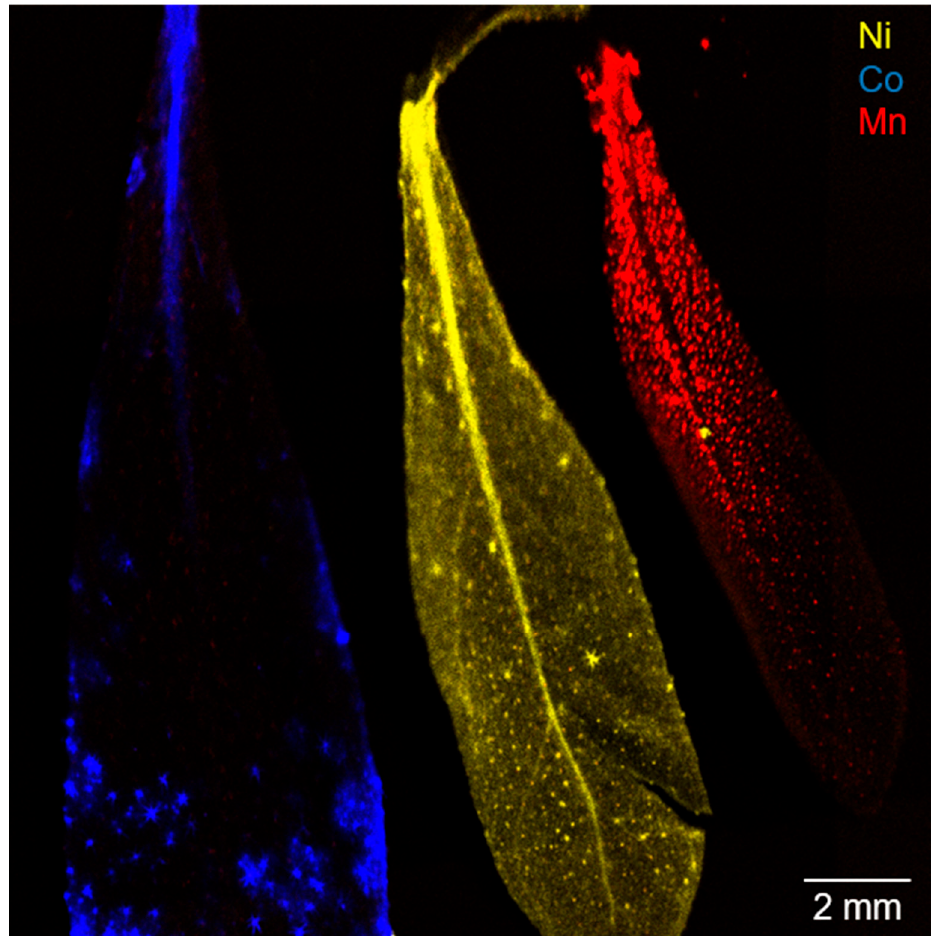
Figure 1. Micro X-ray fluorescence spectroscopy ( µ XRF) image of three alyssum murale leaves from the highest contamination group (level 3). Co localization is indicated in blue, Ni in yellow, and Mn in red.